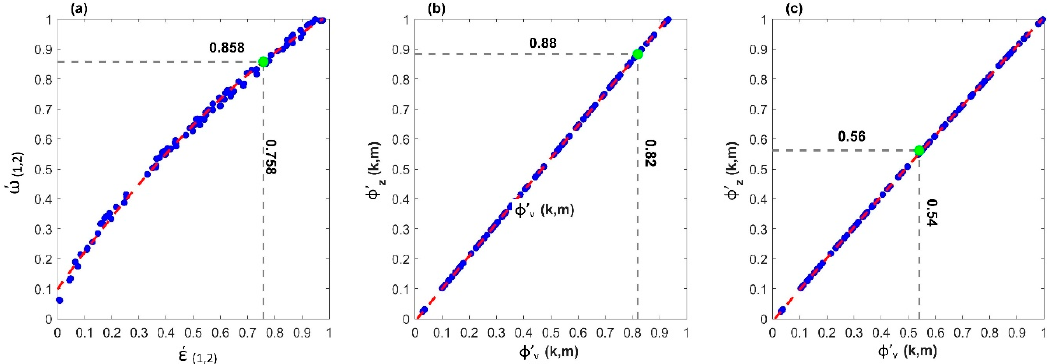
Figure 2. ( a ) An example of Wilks’ technique for precipitation states; ( b ) and ( c ) are examples of Wilks’ technique to obtain ϕ z for T x and WS, respectively, for station k of month